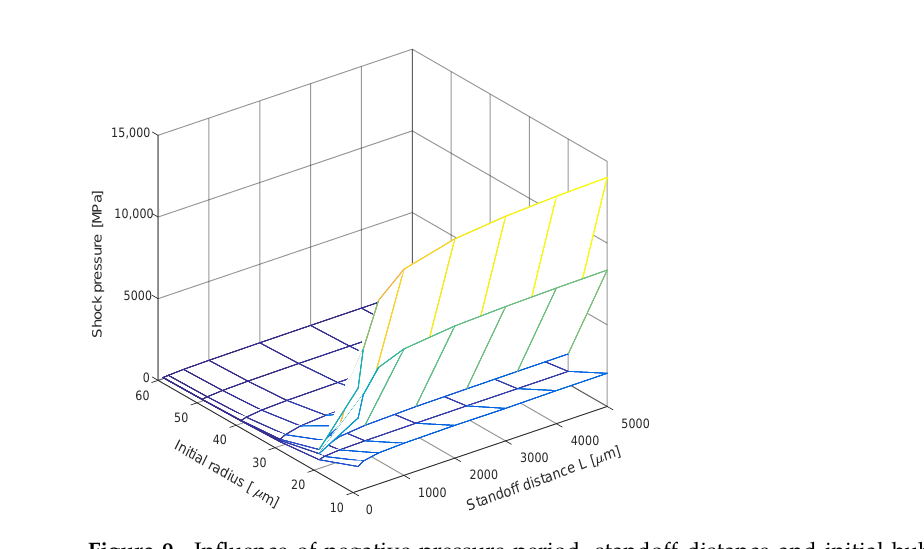
Figure 9. Influence of negative pressure period, standoff distance and initial bubble radius on maximum shock pressure.